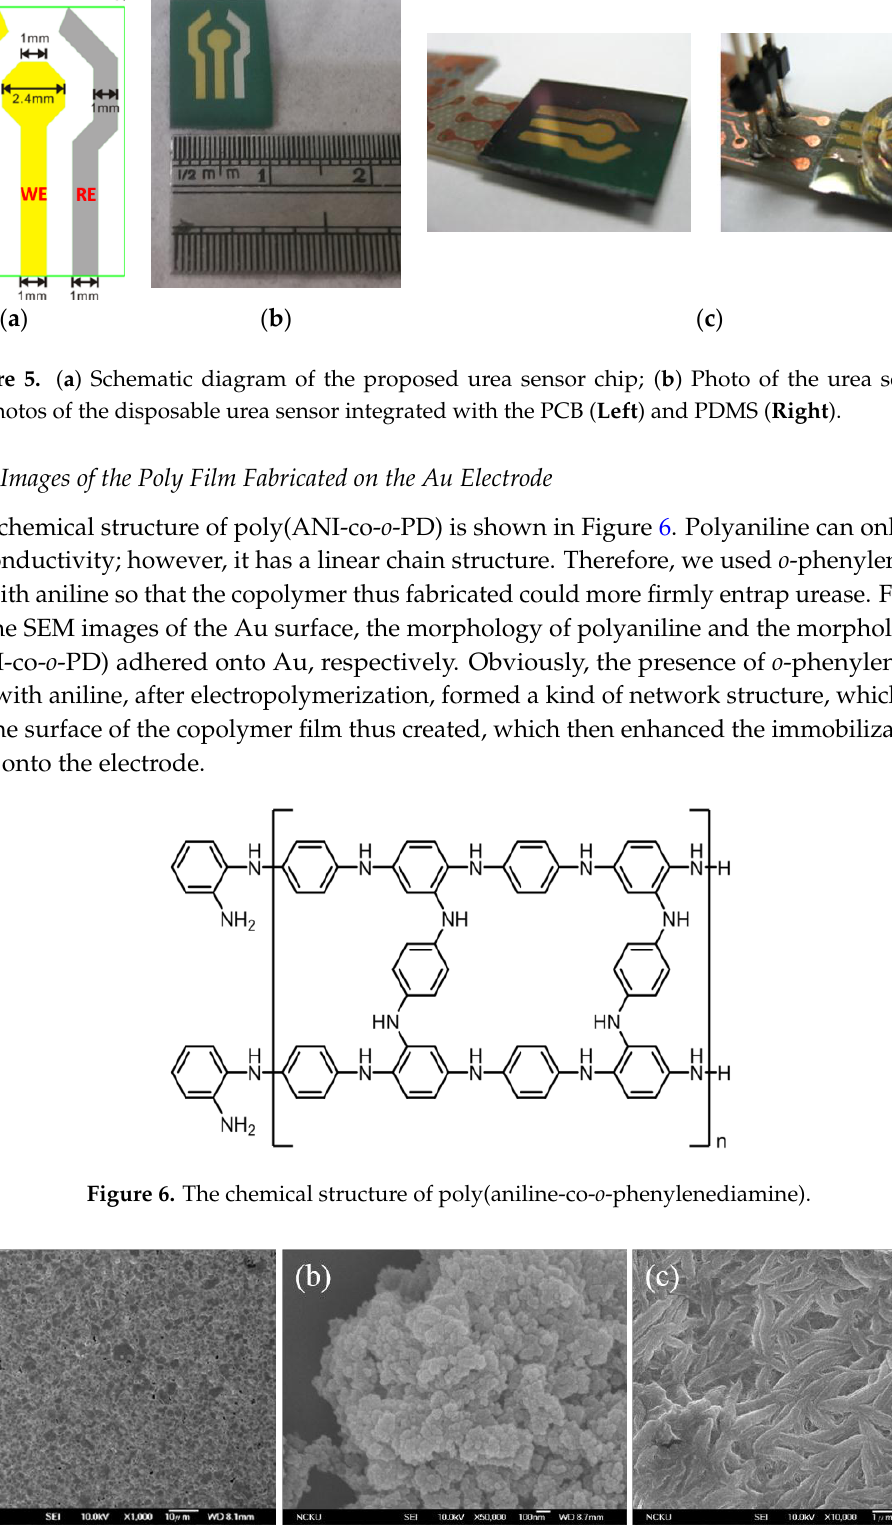
Figure 7. SEM images of the sensing surface of ( a ) Au; ( b ) polyaniline electro-fabricated onto Au; and ( c ) poly (aniline-co- o -phenylenediamine) on Au.